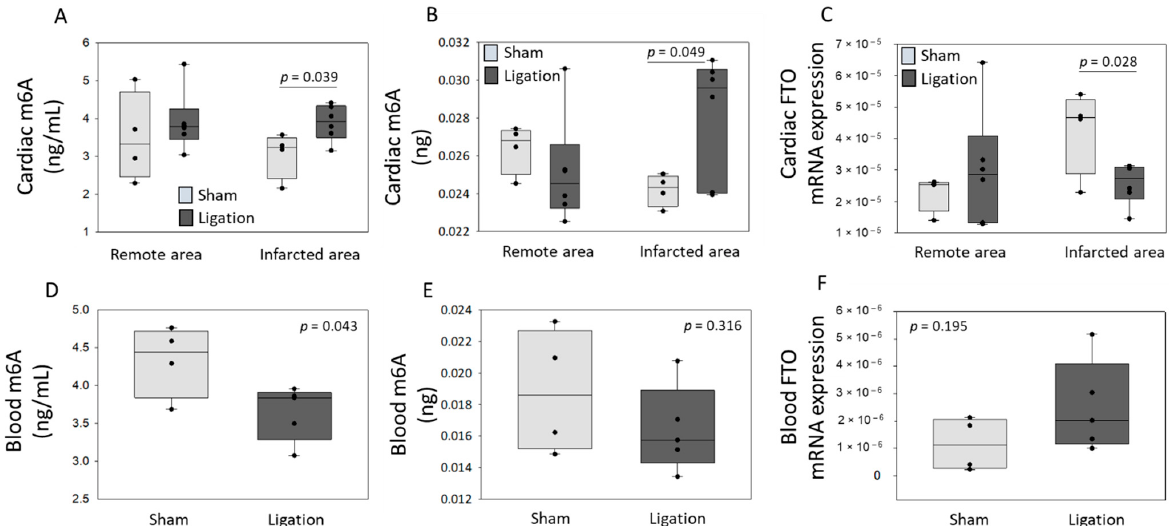
Figure 2. M6A levels and FTO mRNA expression in a rat model of myocardial infarction. Rats were subjected to coronary ligation or sham-operation. After 1 h, rats were sacrificed, cardiac tissue ( n = 6 after ligation and n = 4 sham-operated) and blood samples ( n = 5 after ligation and n = 4 sham-operated) were harvested, and remote and infarcted areas of the heart were dissected before storage. Total RNA was extracted from tissue ( A – C ) and blood ( D – F ) samples. M6A levels were assessed by LC-MS ( A , D ; ng/mL) and by a colorimetric ELISA ( B , E ; ng of m6A contained in 300 ng total RNA). FTO mRNA levels were measured by RT-qPCR and normalized by 18S ( C , F ). p -values for two-group comparisons are